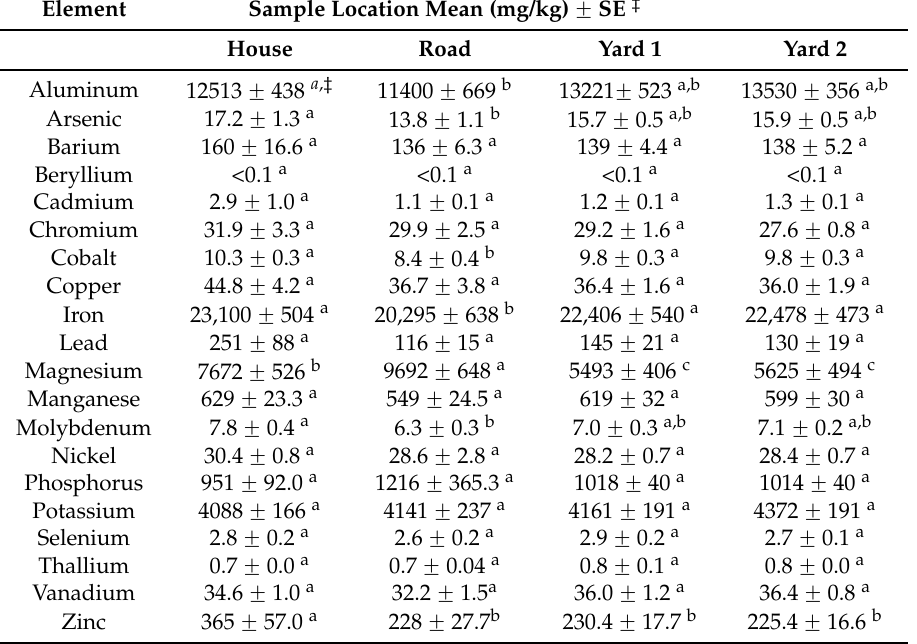
Table 3. Elemental metal concentrations in Stambaugh-Elwood soil sampling locations.